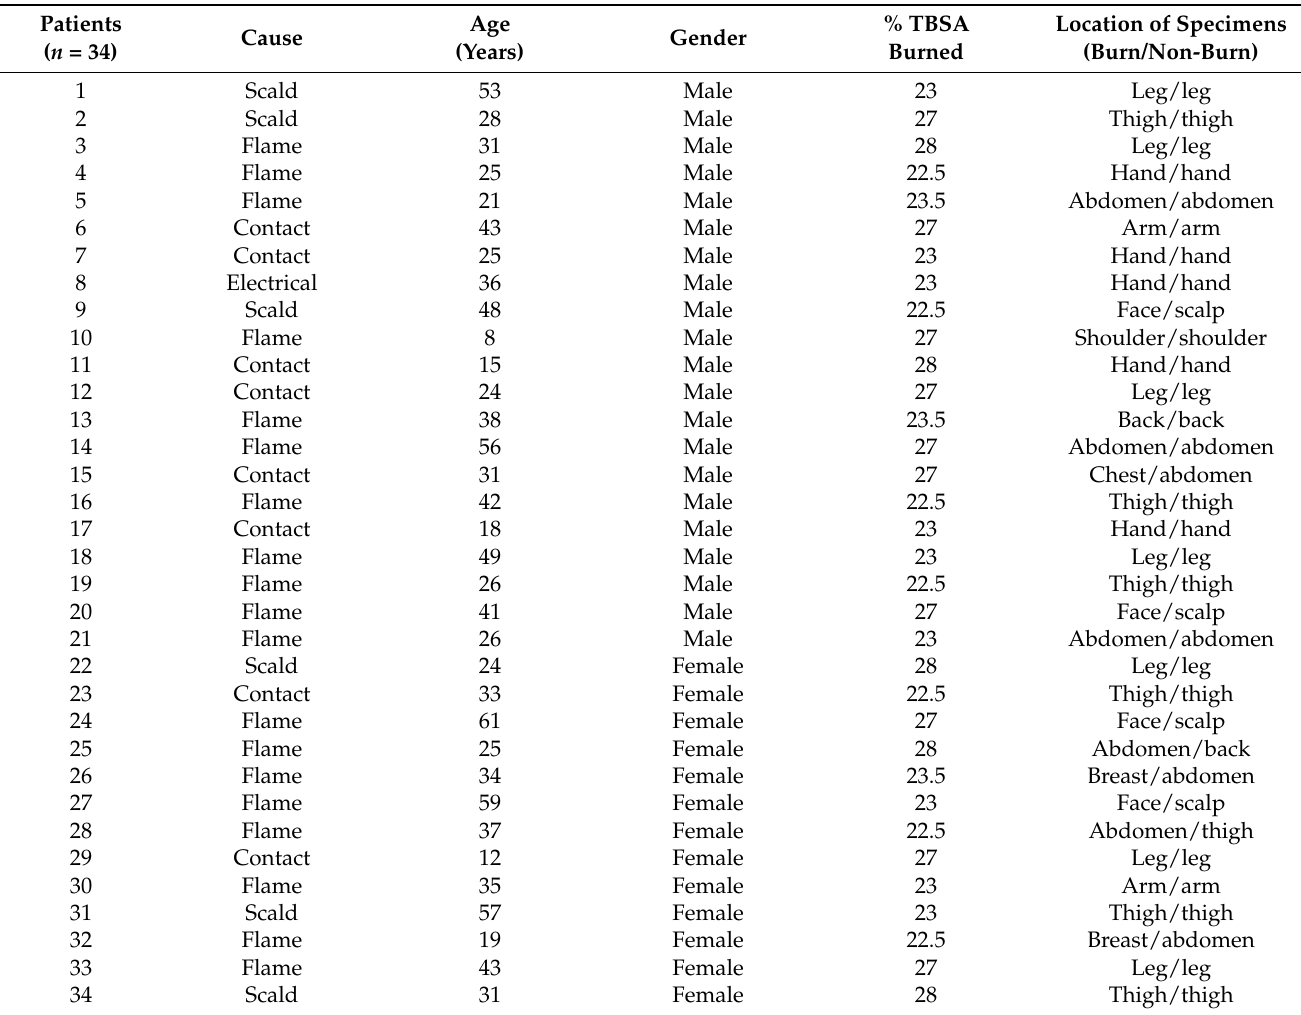
Table 1. Demographic characteristics of burn patients and the nature of the